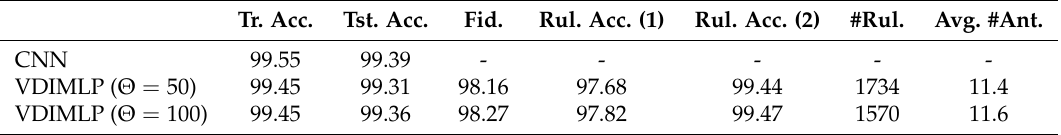
Table 3. Results obtained by a convolutional neural networks (CNN) and its approximation with a virtual discretized interpretable multi-layer perceptron (VDIMLP) subnetwork in the top layers. Tr.